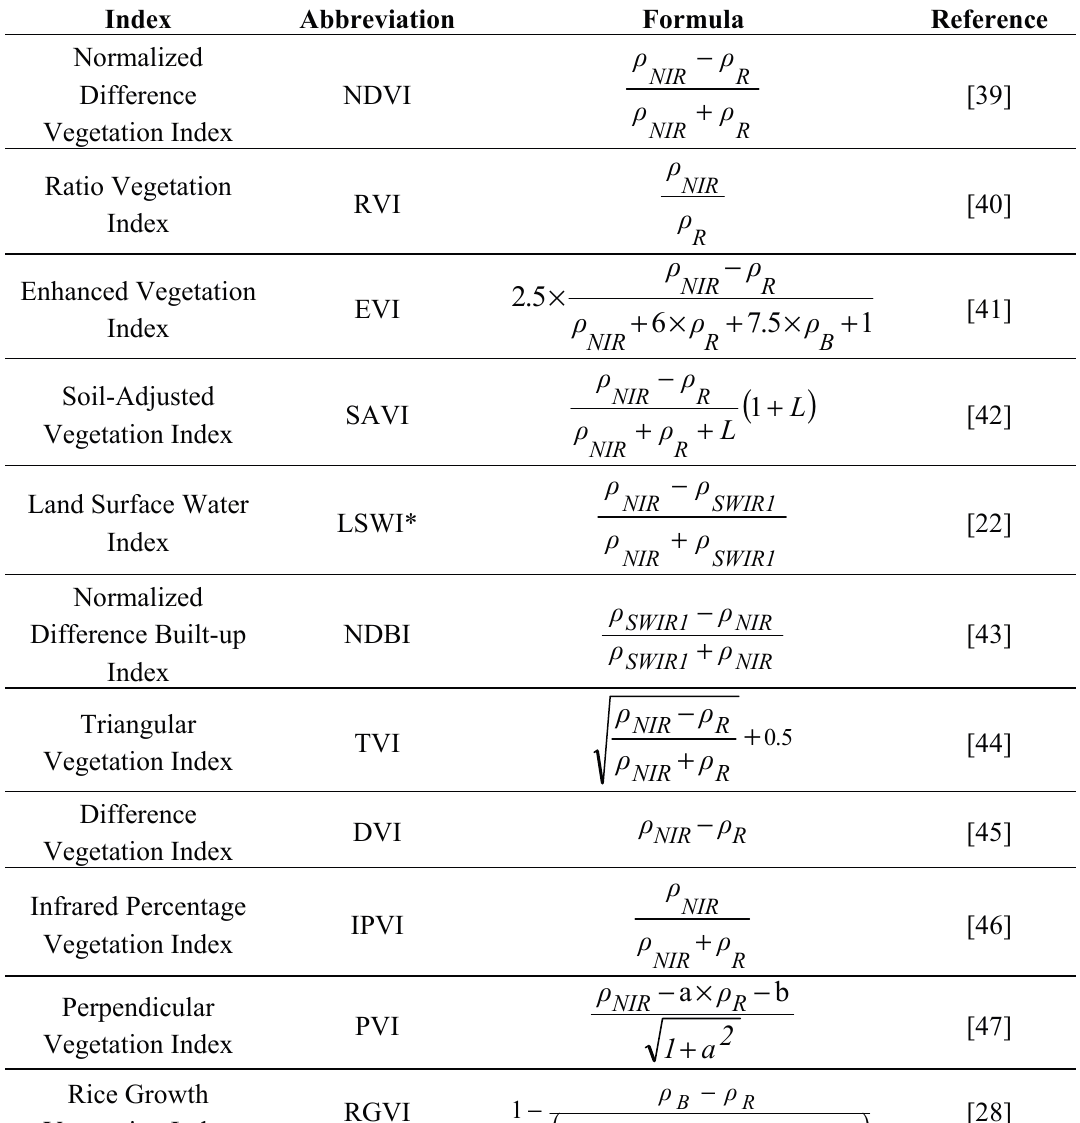
Table 1. List of the common vegetation indices, and their mathematical formula, which have been used in mapping and yield/production